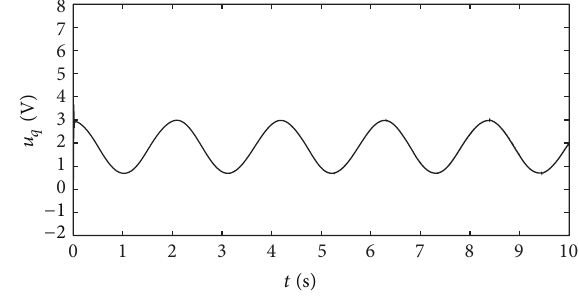
Figure 8: 𝑞 -axis voltage of control input.